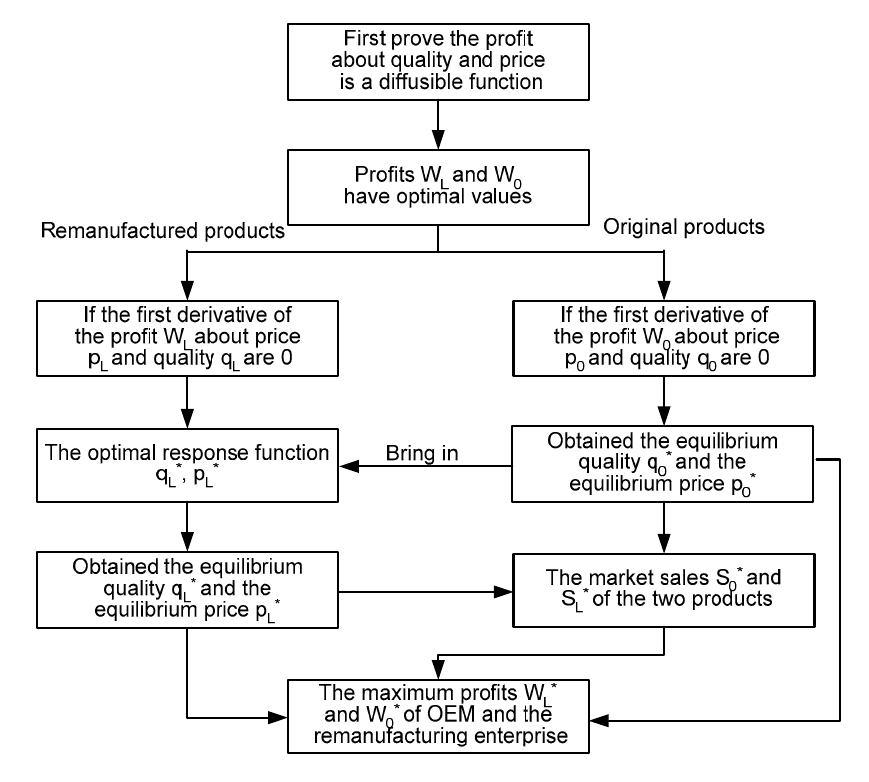
Figure 2. Solving ideas flow diagram.